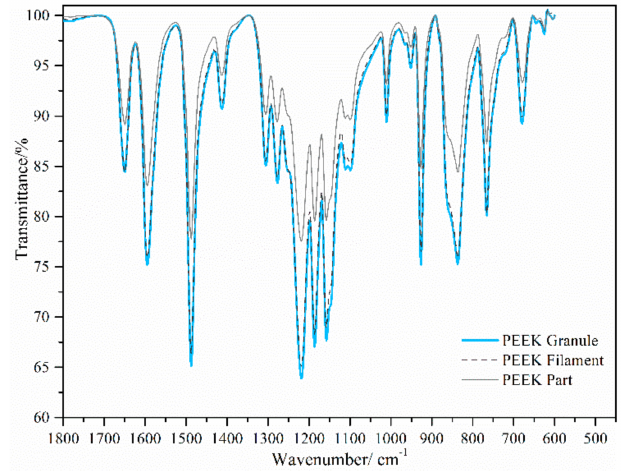
Figure 7. Absorbance spectrum of the PEEK granule, the laboratorial PEEK filament, and the printed PEEK